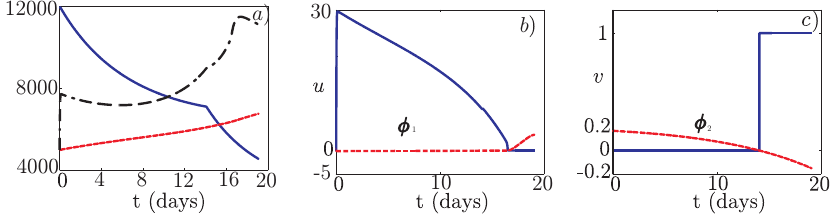
Fig. 13 [Color Online]. a) Evolution of the solutions to Eqs. (52), (53) and (54), p (solid line), s (dotted line), and q (solid-dot line) with the initial conditions ( p 0 , s 0 , q 0 ) = ( 12000 , 5000 , 5000 ) b) Optimal control u ( t ) (solid line) and switching function φ 1 (dotted line) for M = 300 doses and u M = 75 c) Optimal control v ( t ) (solid line) and switching function φ 2 (dotted line) for N = 5 doses and v M =